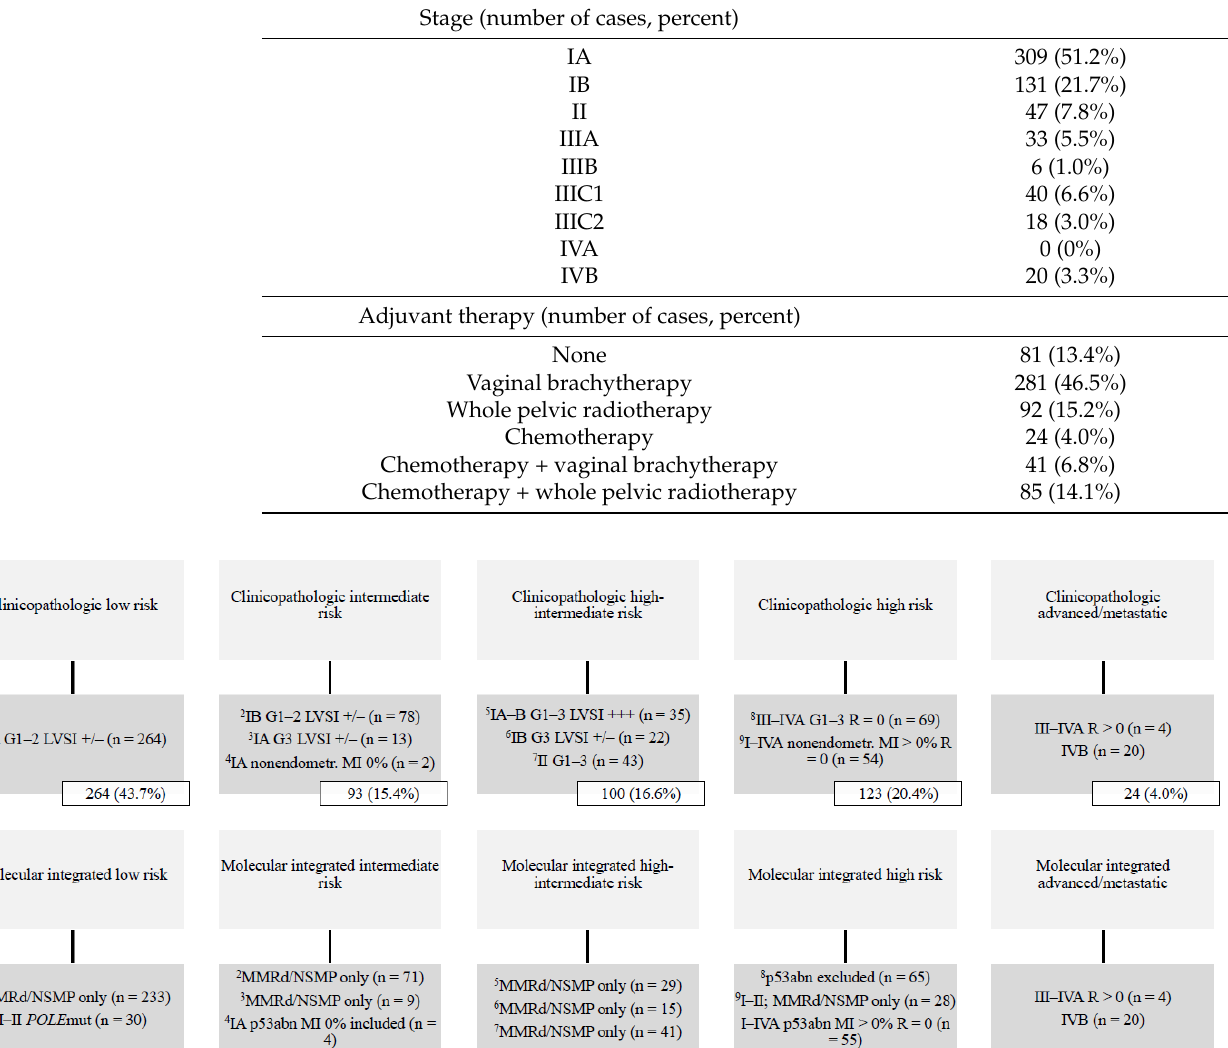
Molecular Subgroup